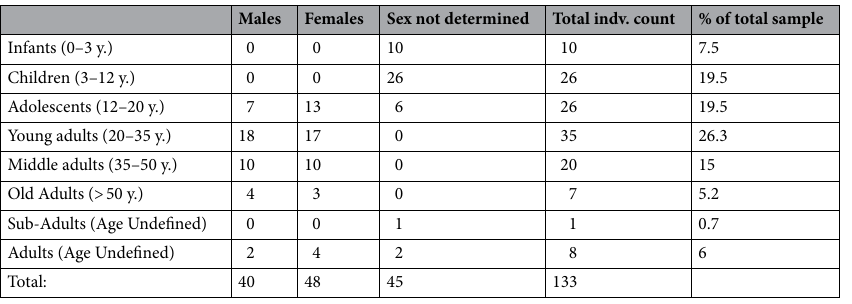
Table 1. Distribution of individuals recovered from four mass graves at the Lazaretto dell’Osservanza by age and